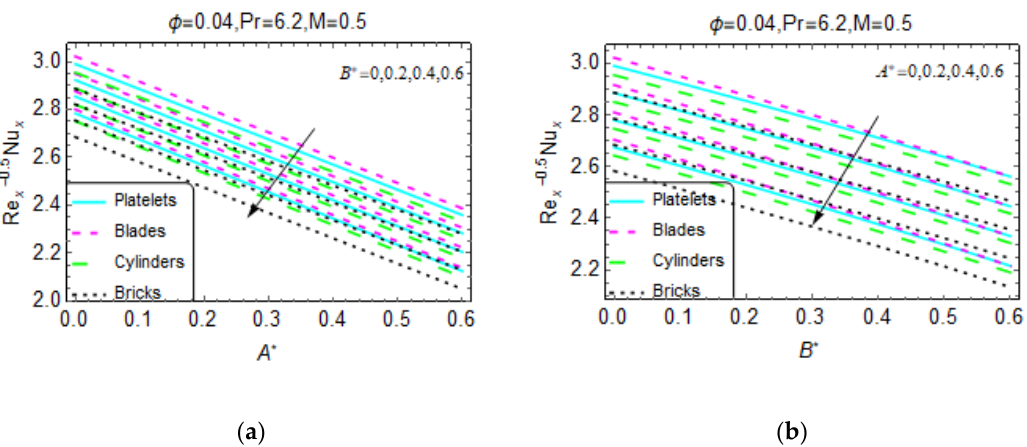
Figure 9. The variations in the Nusselt number for different values of ( a ) B 1 and ( b ) A 1 .